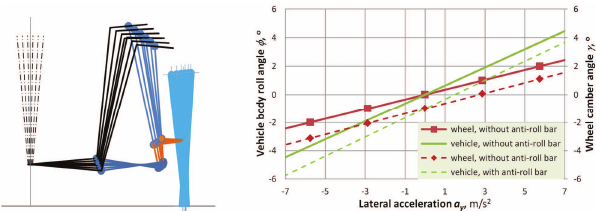
Fig. 4. The wheel camber changing g resulting from vehicle body roll angle f equipped with McPherson suspension [own research]